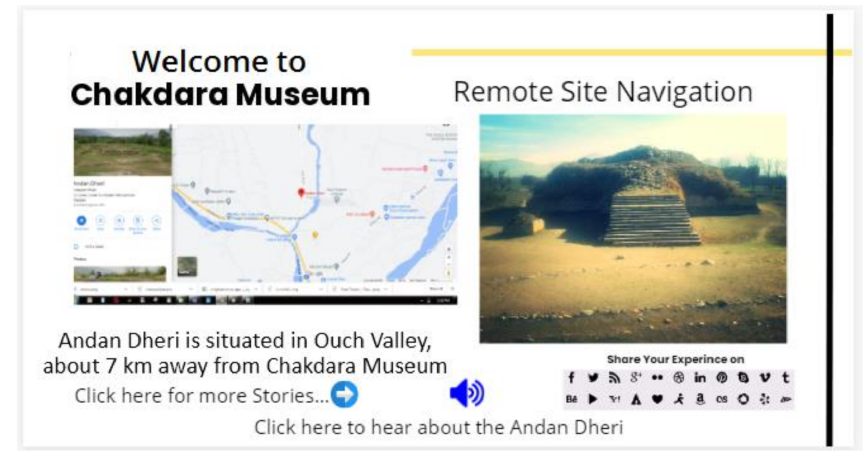
Figure 15. Navigation towards an archeological